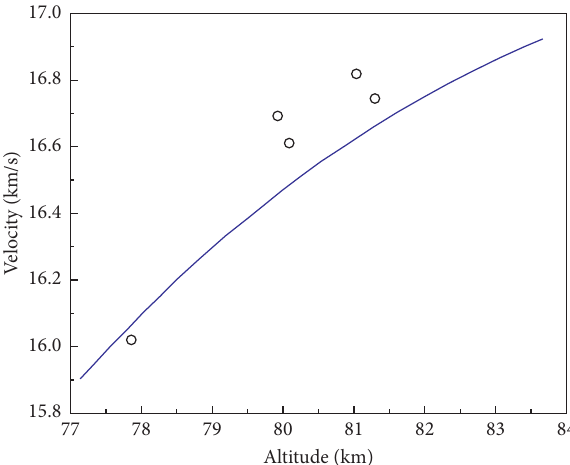
Figure 3: Comparison of results for the meteoroid J4141. The model cannot produce a well-fitting solution since this meteoroid likely suffered an abrupt disruption. This figure can be compared with that shown in Figure 1 of Bellot Rubio et al. disruption episode. We will apply that approach to the lower part of the trajectory of the Chelyabinsk bolide to demon- strate that the obtained parameters are consistent.